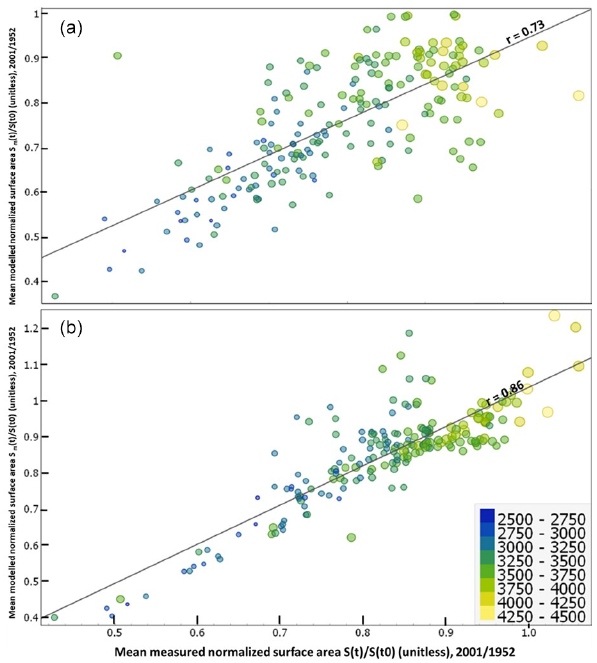
Figure 14. Correlation between the mean normalized measured and modelled surface areas (a) with GSB data transformed to AdM data and (b) with SAFRAN reanalysis data at time t . The colour and size of the ticks represent the mean elevation of the